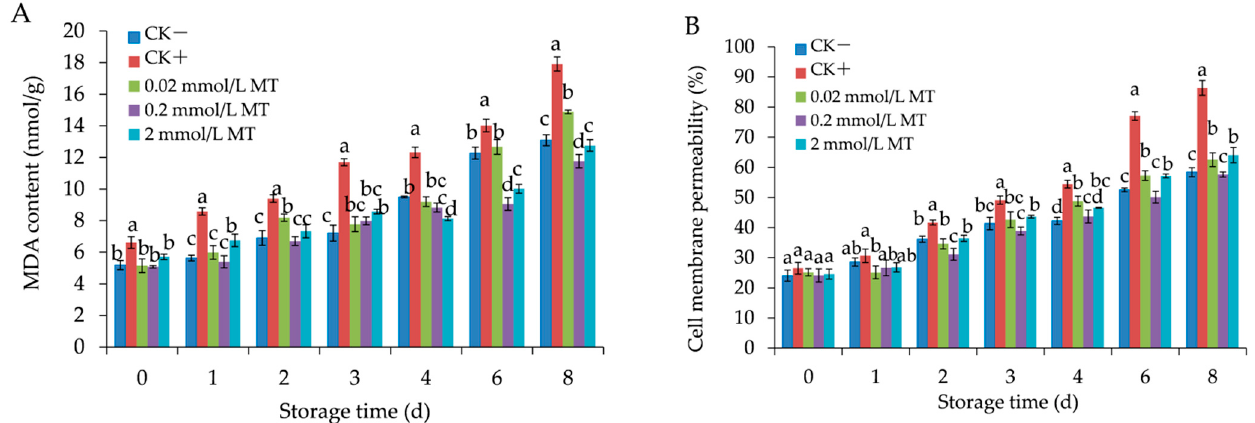
Figure 4. Effect of melatonin treatment on MDA ( A ) and cell membrane permeability ( B ) in grape berries. Data represent means ± S.E. ( n = 3). Duncan’s multiple range test was used to analyse significant differences in data, and letters above the bars represent differences at p < 0.05.